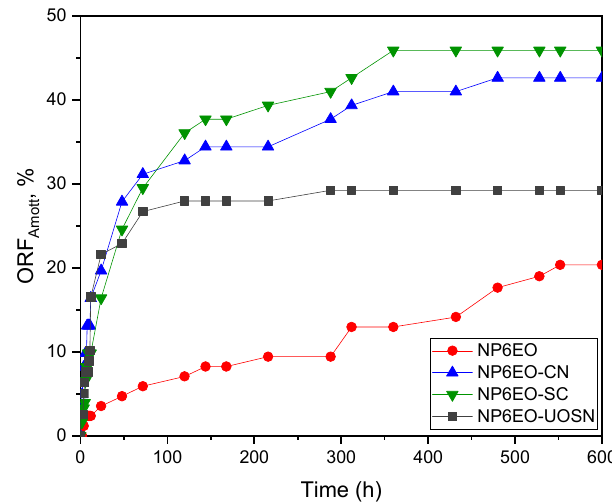
Figure 6. Oil recovery versus time during imbibition process.